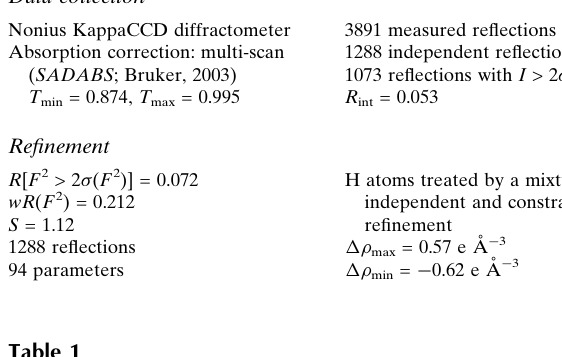
Hydrogen-bond geometry (A˚ , (cid:3)